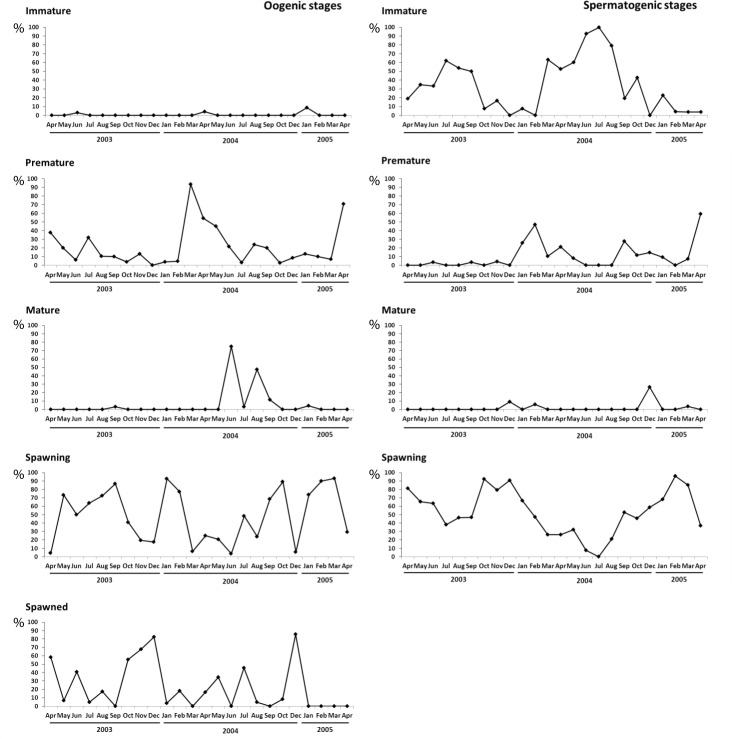
Percentage of individuals at each gonadal stage during the sampled period.